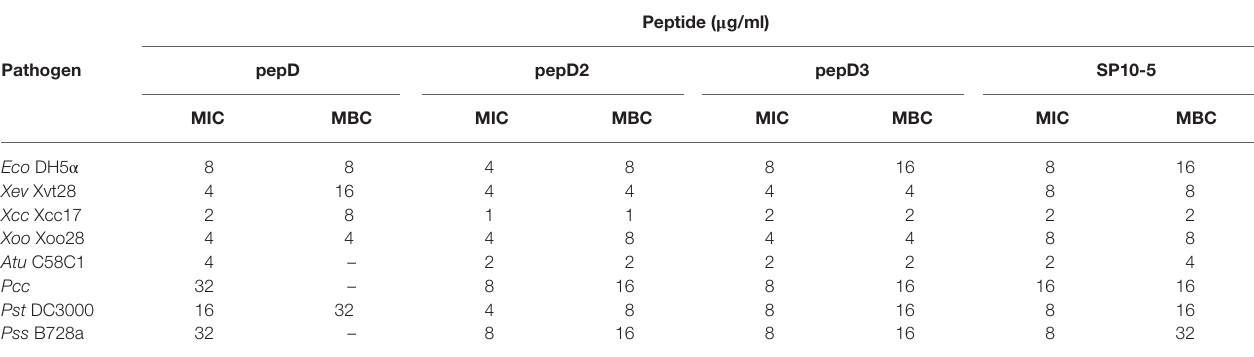
TABLE 4 | Minimal inhibitory concentrations (MICs) and minimal bactericidal concentrations (MBCs) of pepD, pepD2, and pepD3 against E. coli and phytopathogenic bacteria.